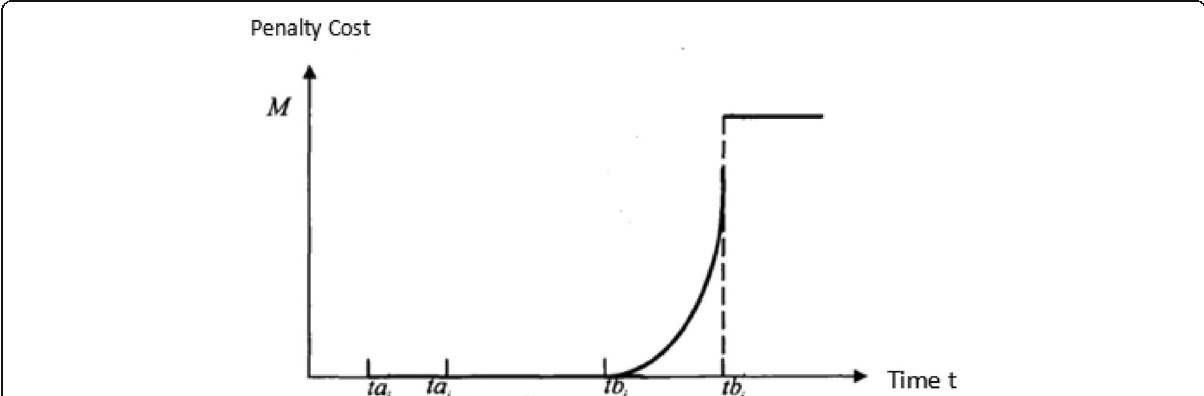
Fig. 7 Fresh product distribution, soft window, penalty cost function. When consumers buy fresh products, they tend to buy products with a longer shelf life, so the probability of fresh products being sold decreases with the length of the remaining shelf life at the end of the sale. And the rate of decline increases as the preservation period approaches. In mathematical functions, exponential functions have the characteristics described above. On the other hand, the penalty cost should be proportional to the total value of the delivery product. So we established the soft time window penalty cost function of fresh product